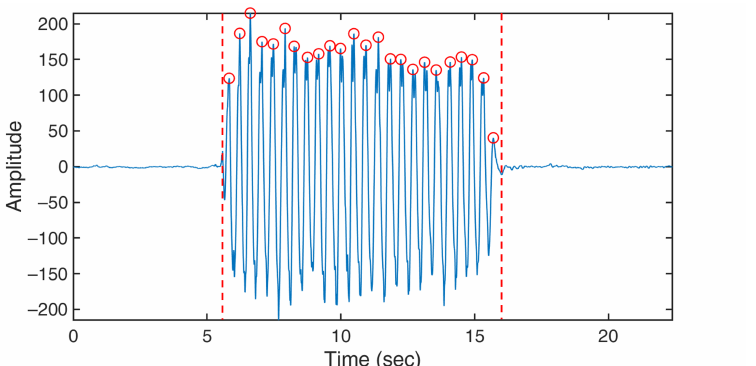
Figure 7. A sample reference data collected from a resting tremor test. The red circles indicate peaks in the data identified by our algorithm and are used to count the number of